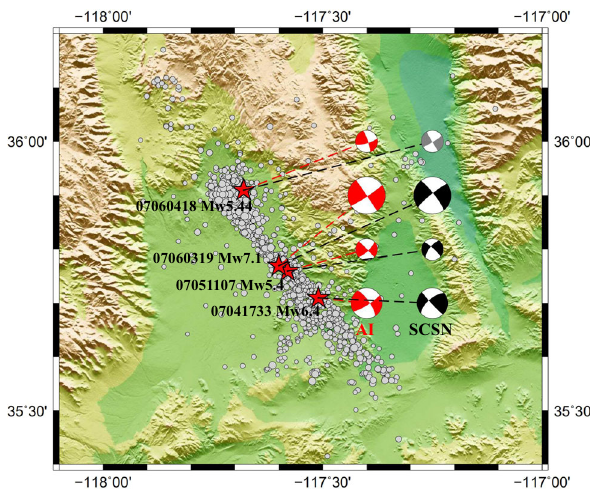
Fig. 3 The application results to the July 2019 Ridgecrest sequence in southern California. Four large earthquakes with magnitudes larger than 5.4 (red stars), including the foreshock of Mw 6.4 and the mainshock of Mw 7.1, are tested. The determined focal mechanisms from arti fi cial intelligence (AI) are shown in red, and the reference solutions from Southern California Seismic Network (SCSN) moment tensor catalog are shown in black for comparison. The northernmost focal mechanism (gray) is inverted using gCAP method since it is not included in SCSN moment tensor catalog. Gray dots show background